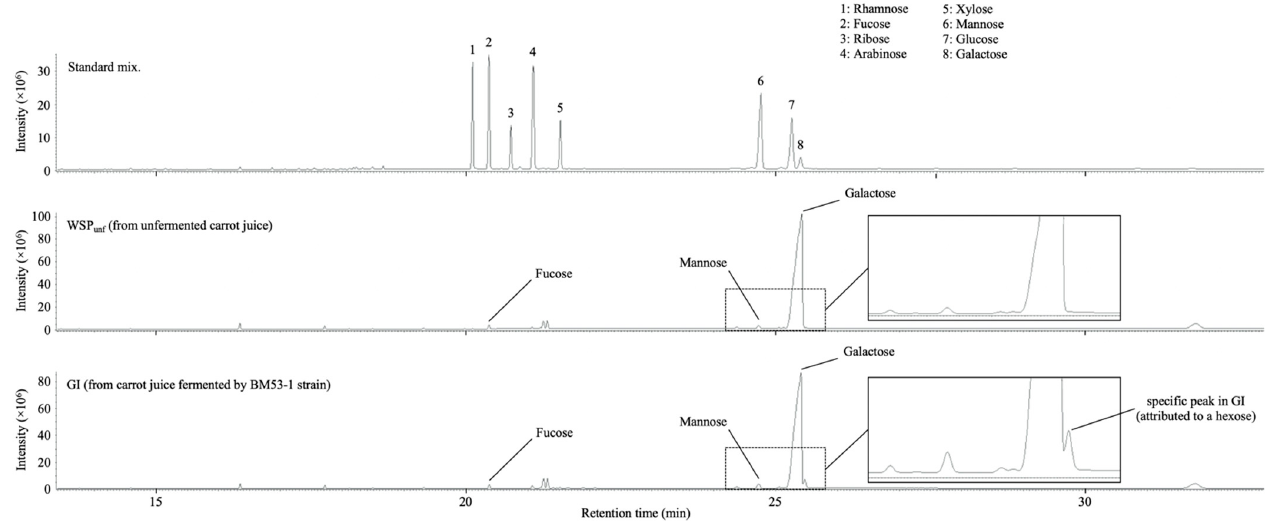
Figure 5. Chromatographic profiles of GC–MS analysis of the GI from the fermented carrot juice medium with the BM53-1 strain. The component monosaccharides are detected as alditol acetate derivatives. The identity of each peak was confirmed by its retention time of standards and mass spectrometry. The dashed squares are enlarged in the right panel.